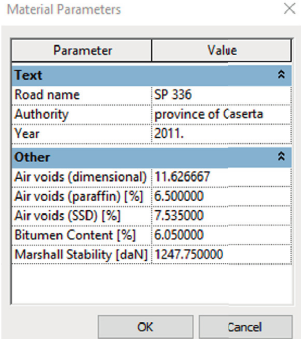
Figure 11: Example of material parameters in the Revit model after the association of worksheet data to the model using